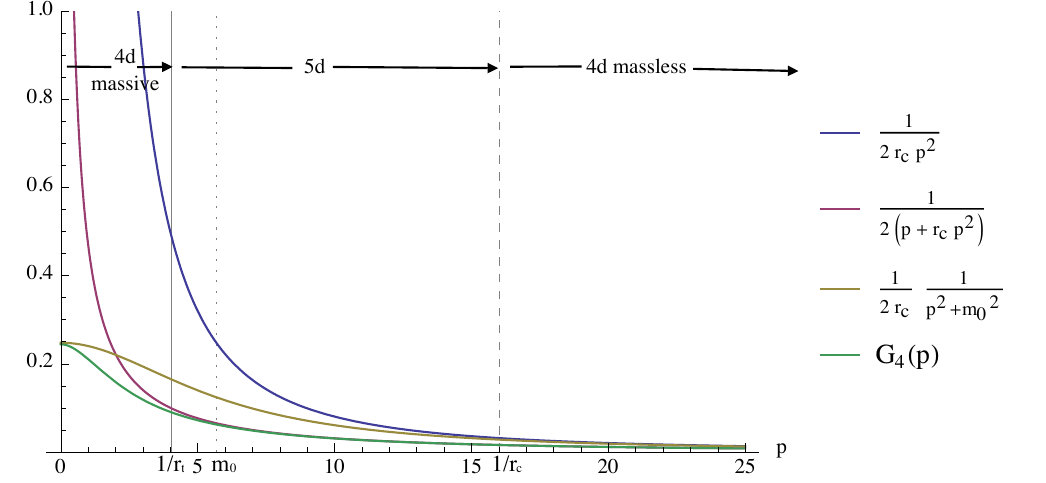
Figure 10 . The e(cid:11)ective brane-to-brane propagator for r t > r c . The vertical lines are from left to right: 1 =r t (solid), m g (dotted), 1 =r c (dashed). All quantities are measured in boundary AdS